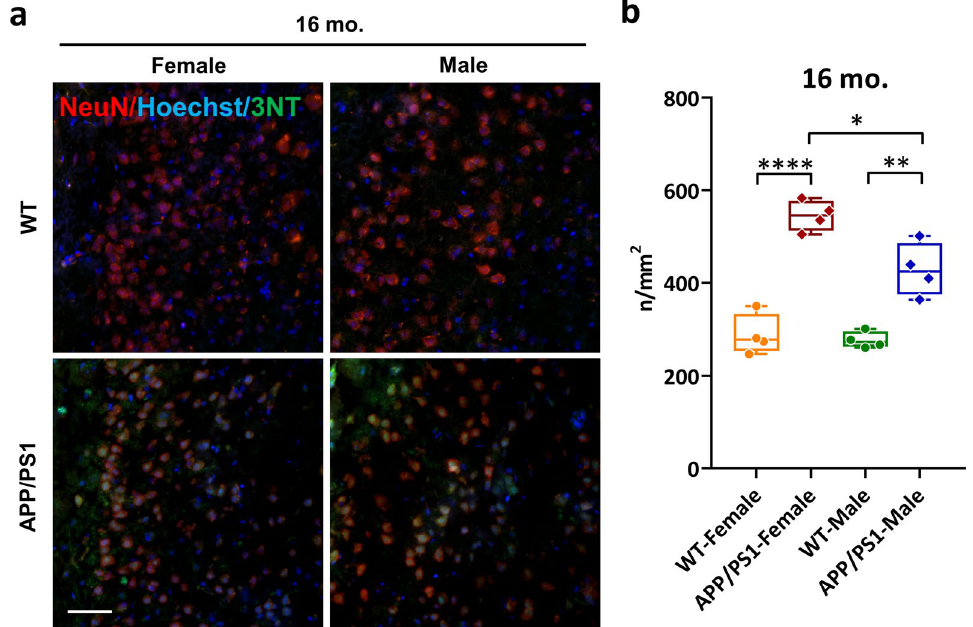
Fig. 6 Oxidative damage is highest in the female APP/PS1 at advanced age. a Representative confocal images showing increased oxidative damage in neurons (NeuN; red) of APP/PS1 mice detected by 3‑nitrotyrosine (3NT; green) adducts in the cortex at 16 mo. of age. Scale bar b Quantification of 3NT‑positive cells in the cortex of age‑matched WT and APP/PS1 mouse brain tissues, n of p value calculated by one‑way ANOVA. Values represent mean